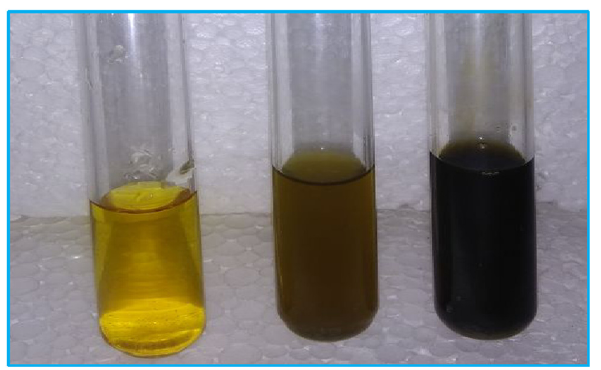
Figure 4: EDAX analysis of ZnNPs biosynthesized from leaf extract of C. baccifera.